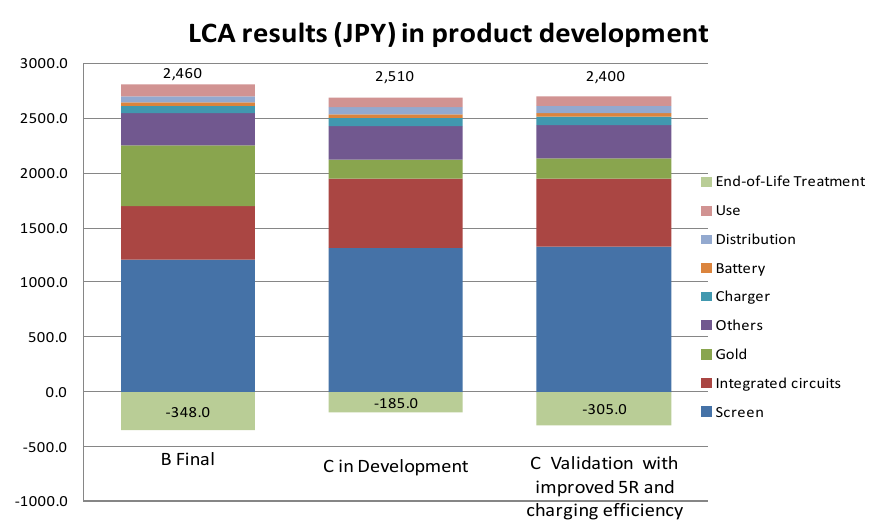
Figure 2. LCA scores used in product development of B and C.